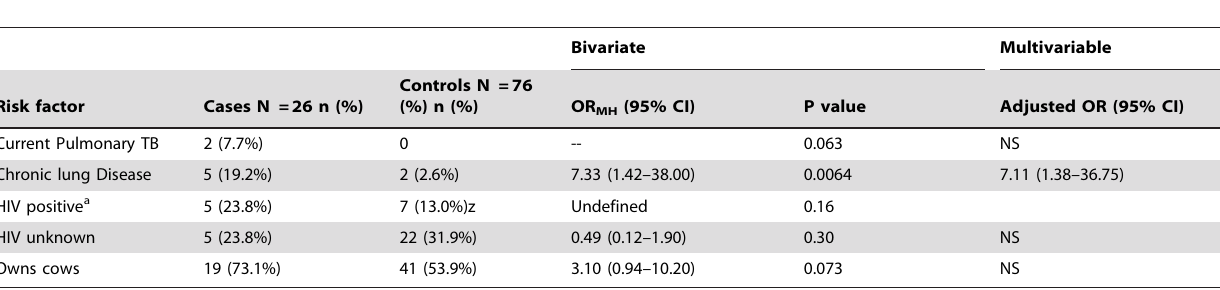
Table 5. Results of bivariate and multivariable analysis of risk factors for hospitalized influenza B, indicating the factors that were included in the multivariate model (p , 0.10), Bondo District, Kenya, 2007-9.